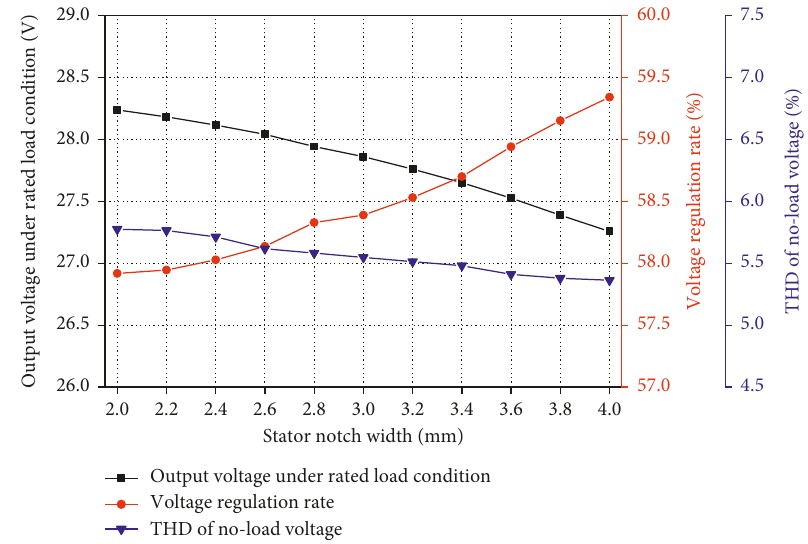
Figure 10: Variation curves of generator output performance with different stator notch widths.